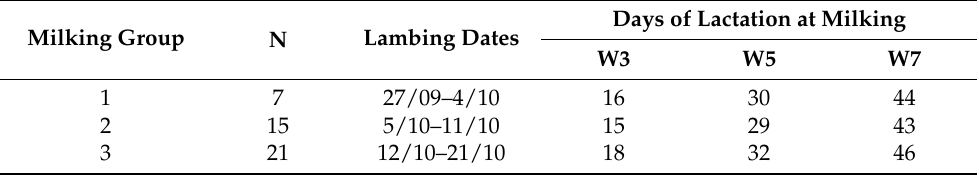
Table 1. Description of the milking groups created based on parturition dates in order to milk all ewe lambs in week three (W3), five (W5) and seven (W7) of lactation. Days of Lactation at Milking Milking Group N Lambing Dates W3 W5 W7 1 7 27/09–4/10 16 30 44 2